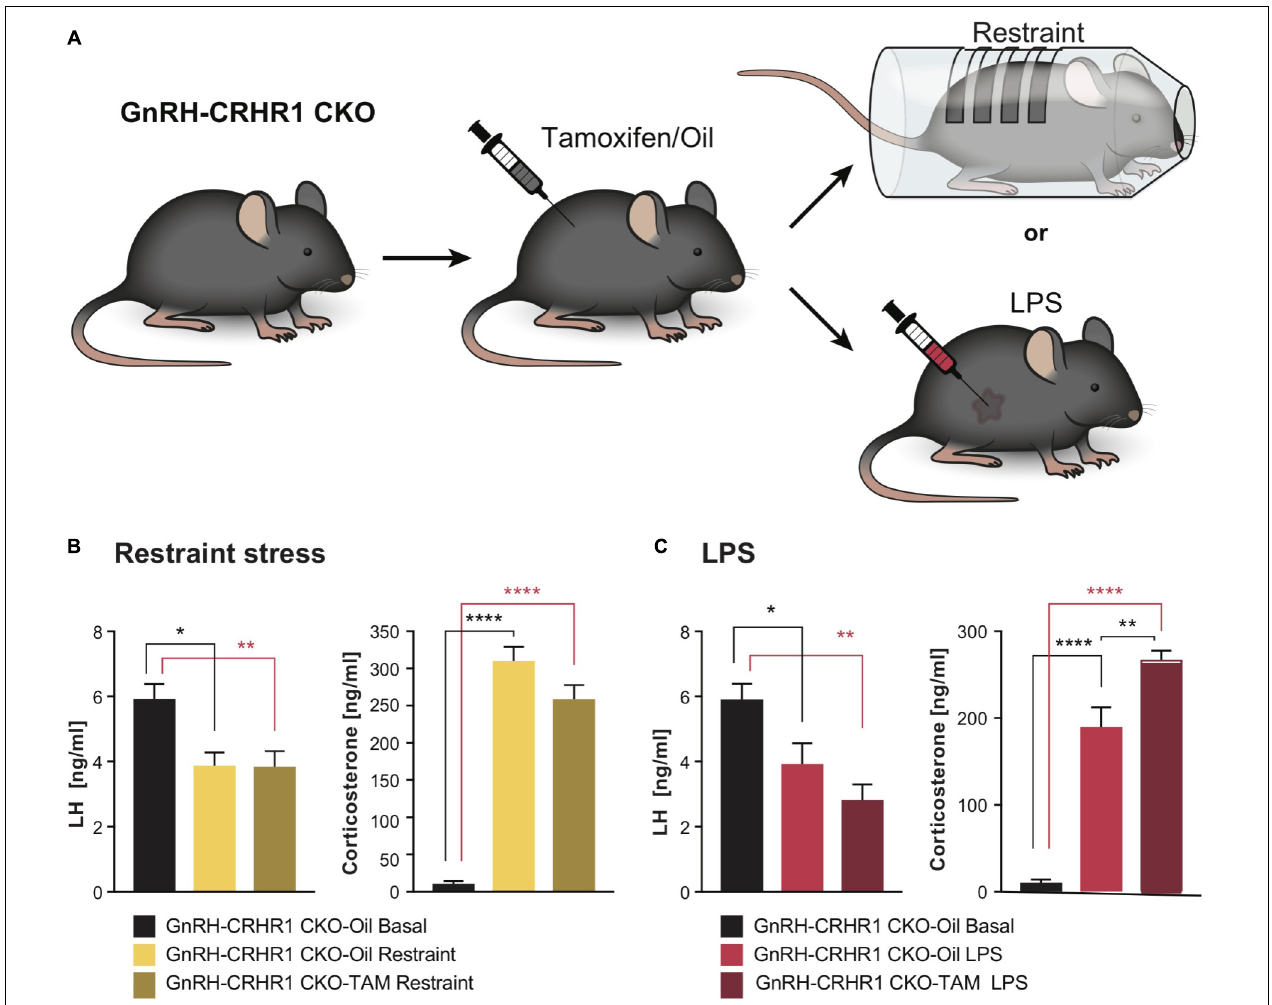
FIGURE 2 | Experimental setups and plasma hormone concentrations in GnRH-CRHR1 CKO mice subjected to acute stressors. (A) Scheme of experimental setup: GnRH-CRHR1 CKO mice were treated with tamoxifen and 4 weeks later were subjected to a 1 h restraint and euthanized immediately after release from the restraint cylinder, or received an LPS injection (2 µ g/g b.w., i.p.) and killed 1 h after the injection. (B) Restraint stress induced a significant decrease of plasma LH concentration in GnRH-CRHR1 CKO-Oil Restraint mice ( n = 5) and in GnRH-CRHR1 CKO-TAM Restraint ( n = 7) compared to basal concentrations in GnRH-CRHR1 CKO-Oil basal mice ( n = 7). No difference was found between stressed GnRH-CRHR1 CKO mice, TAM and oil treated. One-way ANOVA, F (2, 16) = 7,56, p = 0.0049, followed by Tukey’s post hoc test: GnRH-CRHR1 CKO-Oil Basal vs. GnRH-CRHR1 CKO-Oil Restraint, ∗ p = 0.0171, GnRH-CRHR1CKO-oil Basal vs. GnRH-CRHR1CKO-TAM Restraint, ∗∗ p = 0.0081, and GnRH-CRHR1CKO-Oil Restraint vs. GnRH-CRHR1 CKO-TAM Restraint, NS, not significant, p = 0.9907. Restraint stress induced a significant increase of plasma CS concentration in GnRH-CRH-R1 CKO mice Oil and TAM treated compared to the basal levels of GnRH-CRHR1 CKO-Oil basal mice. One-way ANOVA, F (2, 16) = 136.5, p < 0.0001, followed by Tukey’s post hoc test (for GnRH-CRHR1 CKO-Oil Basal vs. GnRH-CRHR1 CKO-Oil Restraint and for GnRH-CRHR1 CKO-Oil Basal vs. GnRH-CRHR1 CKO-TAM Restraint, ∗∗∗∗ p < 0.0001, and for GnRH-CRHR1 CKO-Oil Restraint vs. GnRH-CRHR1 CKO-TAM Restraint, NS, p = 0.0568). (C) LPS, like restraint stress, resulted in a similar decrease of plasma LH concentration in GnRH-CRHR1 CKO mice Oil-treated ( n = 8) and TAM-treated ( n = 9) compared to the basal plasma LH concentration of GnRH-CRHR1 CKO-Oil mice ( n = 7). One-way ANOVA, F (2, 21) = 9.036, p = 0.0015, Tukey’s post hoc test: GnRH-CRHR1 CKO-Oil Basal vs. GnRH-CRHR1 CKO-Oil LPS, ∗ p = 0.0387, GnRH-CRHR1 CKO-Oil Basal vs. GnRH-CRHR1 CKO-TAM LPS, ∗∗ p = 0.0010, GnRH-CRHR1 CKO-Oil LPS vs. GnRH-CRHR1 CKO-TAM LPS, NS, not significant, p = 0.2786. For CS levels, ANOVA, F (2, 21) = 86.78, p < 0.0001, followed by Tukey’s multiple comparisons (GnRH-CRHR1 CKO-Oil Basal vs. GnRH-CRHR1 CKO-Oil LPS, ∗∗∗∗ p < 0.0001, GnRH-CRHR1 CKO-Oil Basal vs. GnRH-CRHR1 CKO-TAM LPS, ∗∗∗∗ p < 0.0001, and for the GnRH-CRHR1CKO-Oil LPS vs. GnRH-CRHR1 CKO-TAM LPS, ∗∗ p =